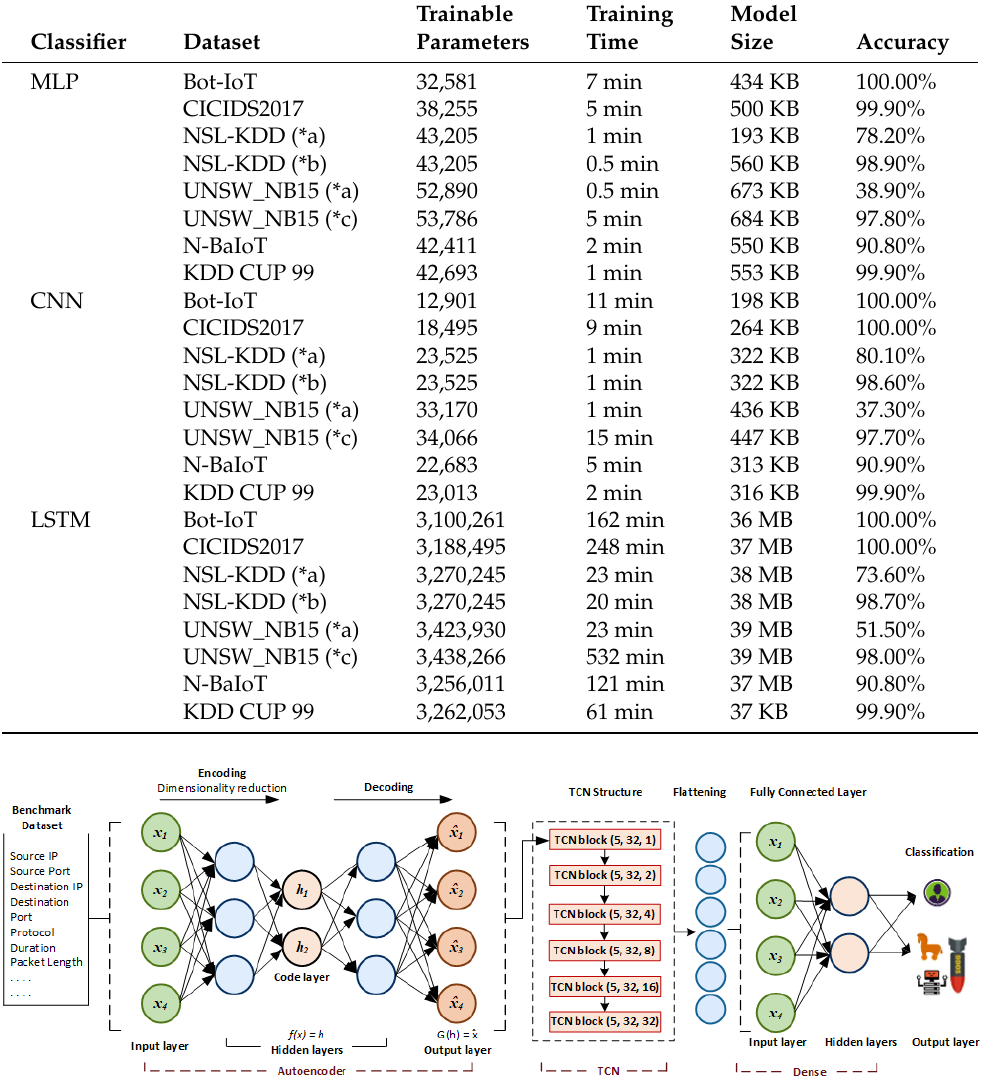
Figure 2. Autoencoder + TCN